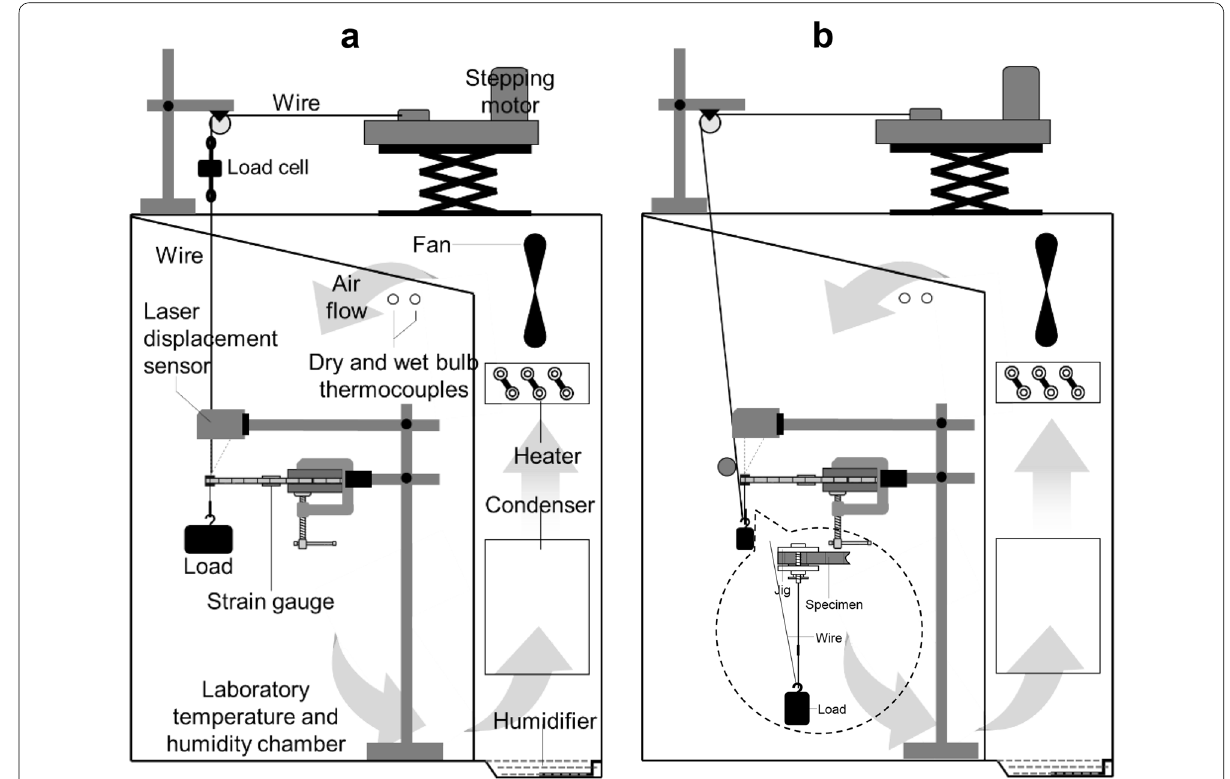
Fig. 2 Schematic diagram of the tests conducted in this study. a Rupture load test; b creep test